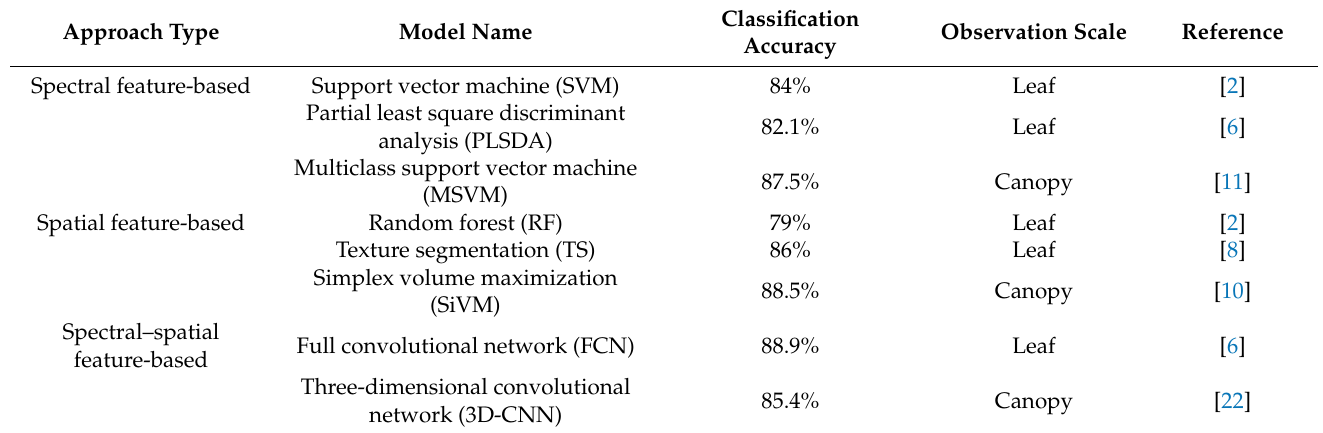
Table 1. Comparison of the existing models for potato late blight disease